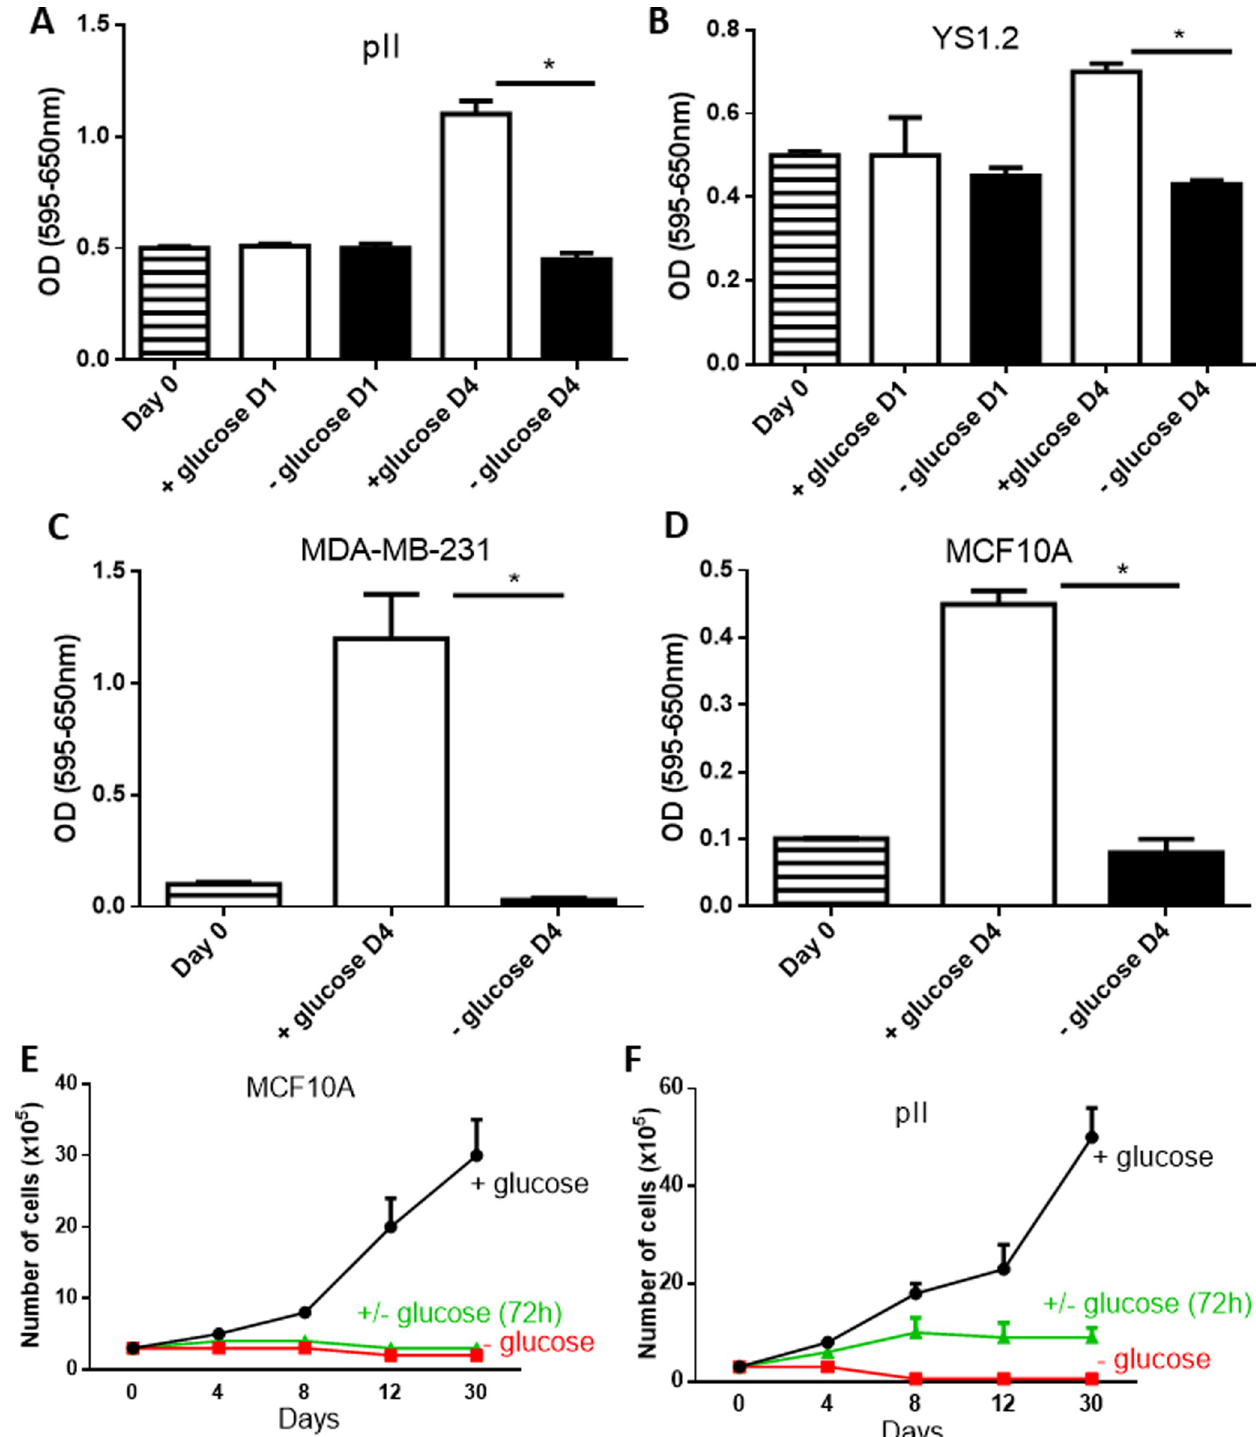
Fig 1. Effect of glucose starvation on cell proliferation. pII (panel A) and YS1.2 (panel B) cell density was determined, using the MTT assay, at seeding day (day 0, hatched bars), and at days 1 and 4 (D 1 and D4) after culture in medium containing glucose (open bars) or without glucose (solid bars). The degree of proliferation of MDA-MB-231 and MCF10A as indicated in panels C-D was determined at day 4 (D 4) after culture in medium with (open bars) or without (closed bars) glucose. Panel E (MCF10A) and panel F (pII), show growth of cells (number of cells were measured using hemocytometer) cultured in + glucose medium (black line),—glucose medium (red line), or these two media alternated every 72 h (green line). Histobars represent means ± SEM of at least 3 independent determinations. � denotes significant difference from cells cultured in + glucose medium with p < 0.05.